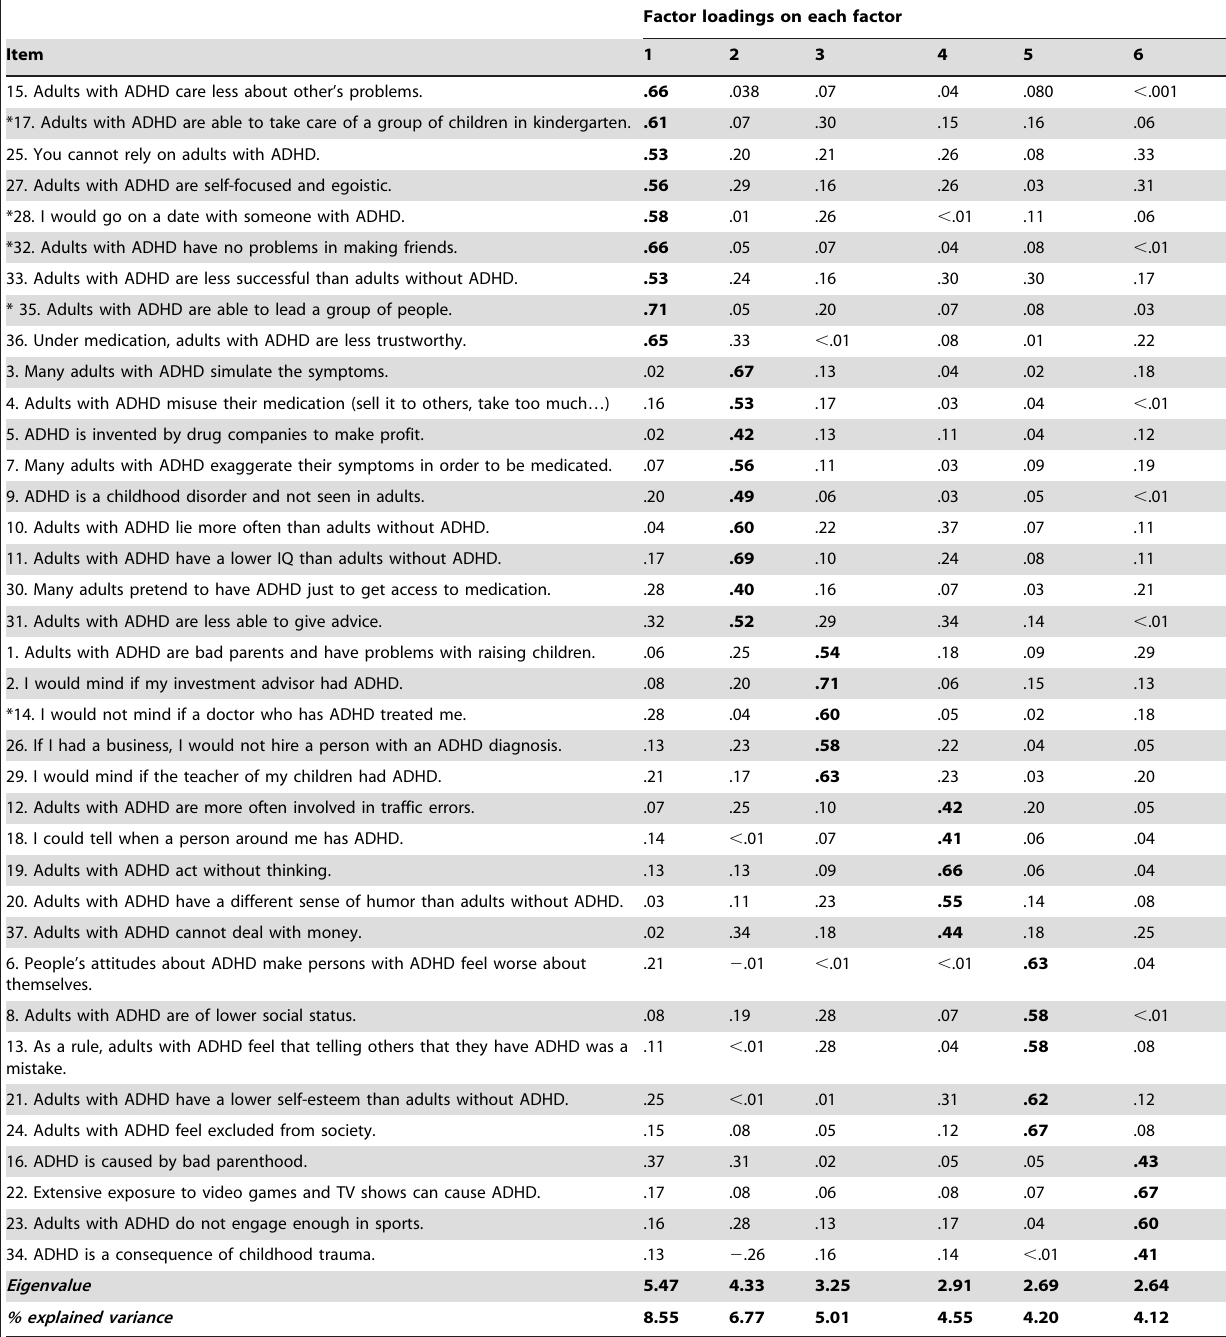
Table 3. Summary of results of the principal component analysis